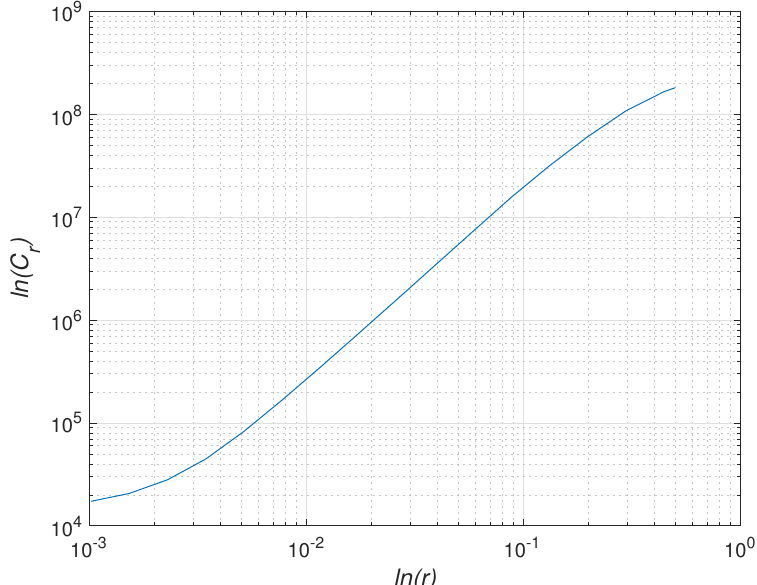
Figure 6. C r vs. ln ( r ) plot for calculating the Correlation